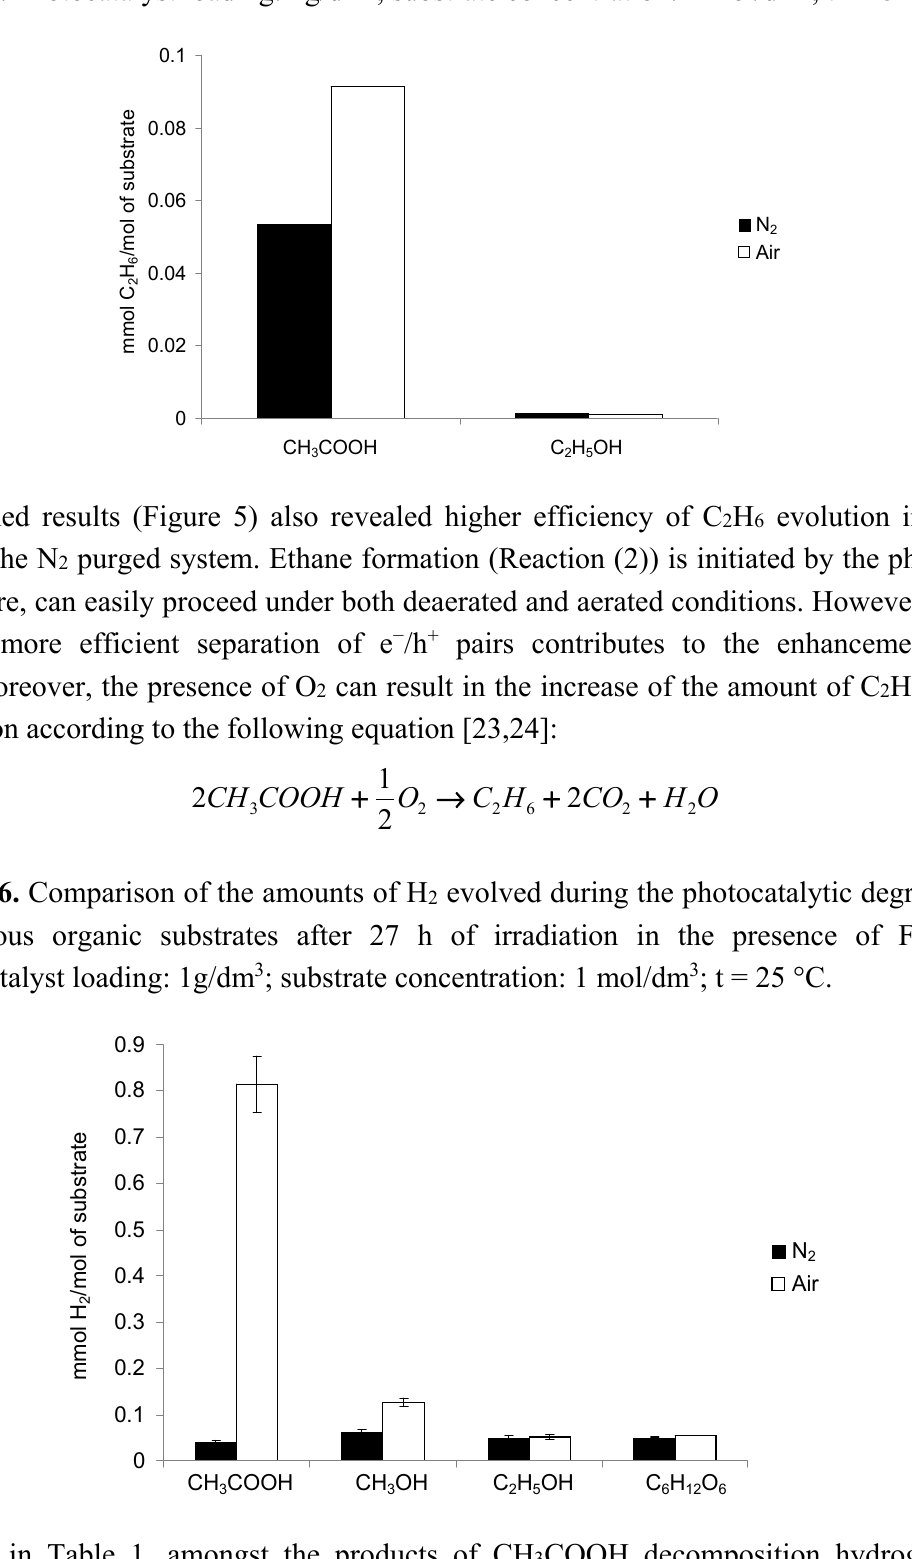
Figure 5. Comparison of the amounts of C 2 H 6 evolved during the photocatalytic degradation of various organic substrates after 27 h of irradiation in the presence of Fe/TiO 2 . Photocatalyst loading: 1g/dm 3 ; substrate concentration: 1 mol/dm 3 ; t = 25 °C.